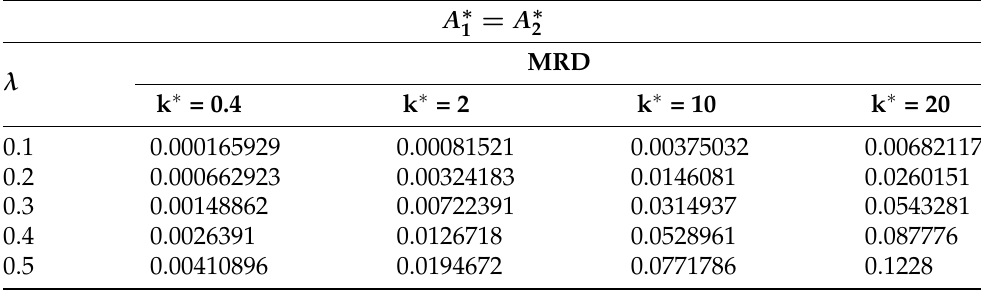
Table 10. Simply supported beam subjected to a non-dimensional uniform load q ∗ y = − 1. Non- = A ∗ dimensional parameters A ∗ versus the non-dimensional length-scale parameter λ evaluated 2 1 by the non-dimensional Winkler parameter k ∗ ∈ { 0.4,2,10,20 } in the MRD